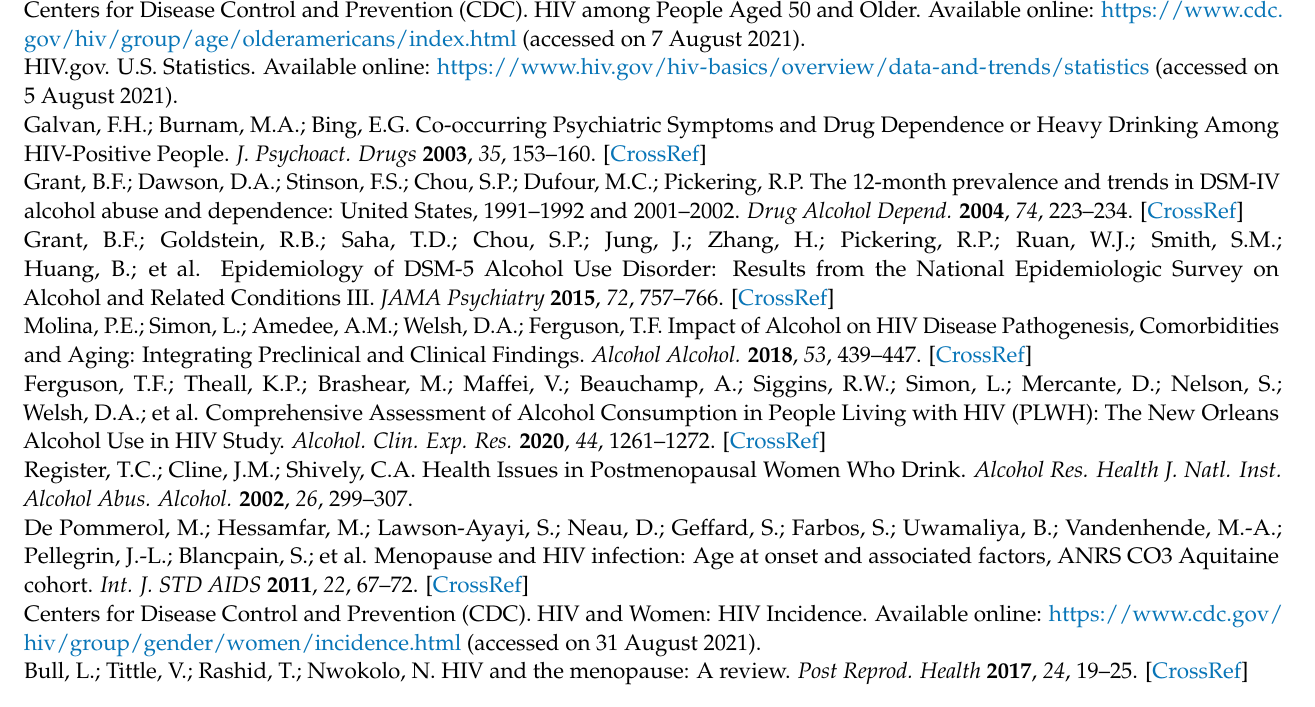
cell populations; Figure S2: Gating strategy to assess CD4 + T cell SIV co-receptor expression; Figure S3: Spearman correlations of viral load, DNA and RNA with CD4 + HIV co-receptor ex- pression; Table S1: Spearman correlation analysis of SIV viral load and immune cell